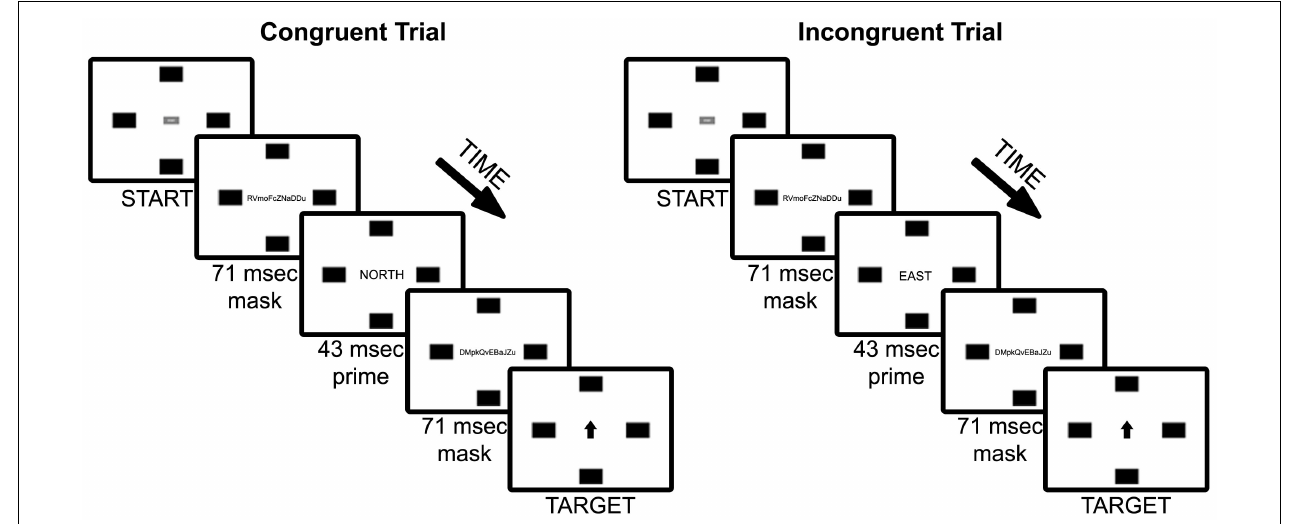
FIGURE 1 | Experiment 1 trial sequence of example congruent and incongruent (90˚) trial types. Note that font sizes of masks, primes, and targets are increased for figure legibility.